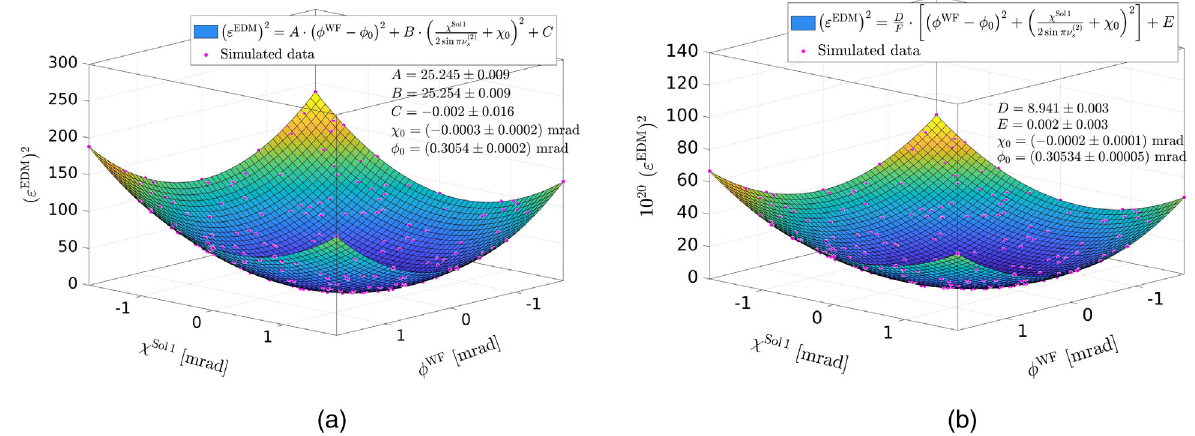
FIG. 22. Fits to the simulated data for the resonance strength ð ε EDM Þ 2 as a function of ð ϕ WF